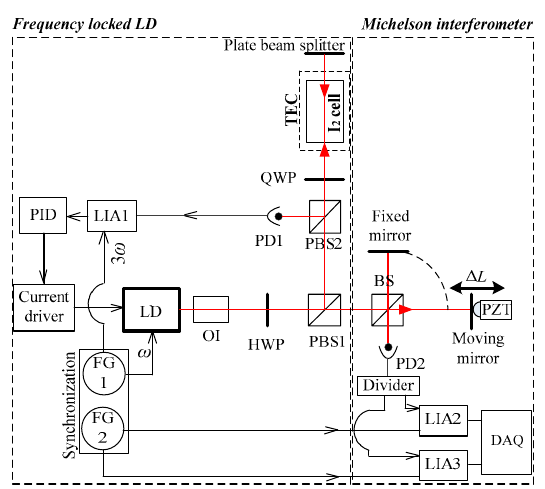
Figure 1. Frequency-locked displacement-measuring interferometer. LD: laser diode; OI: optical isolator; HWP: half-wave plate; PBS: polarized beam splitter; BS: beam splitter; PD: photodetector; QWP: quarter-wave plate; PZT: piezoelectric transducer; LIA: lock-in amplifier; TEC: thermal